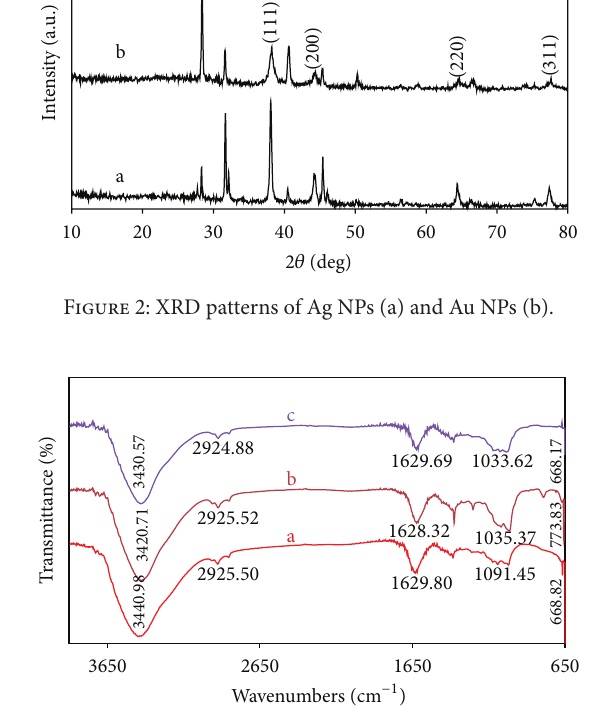
Figure 3: FT-IR spectra of T. conoides extract (a), Ag NPs (b), and Au NPs